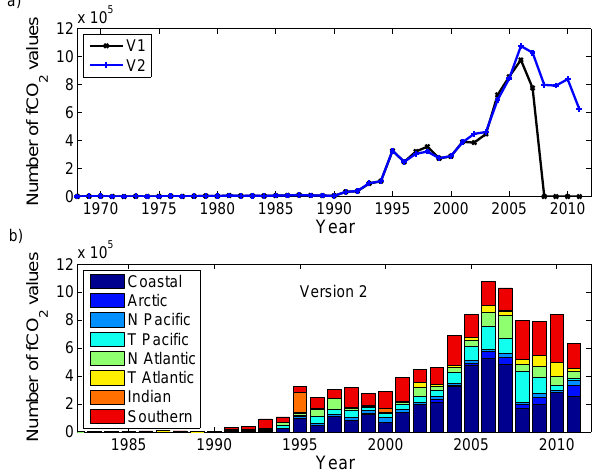
Figure 1. (a) The number of surface water f CO 2 values per year in SOCAT versions 1 and 2 and (b) per region per year in version 2. The SOCAT operationally defined region names are the Coastal Seas, the Arctic Ocean, the North Pacific Ocean, the Tropical Pa- cific Ocean, the North Atlantic Ocean, the Tropical Atlantic Ocean, the Indian Ocean and the Southern Ocean (Fig. 5, Table 5). These data points originate from data sets with flags of A, B, C or D and have a WOCE flag of 2. The subsequent figures only show f CO 2 values with these